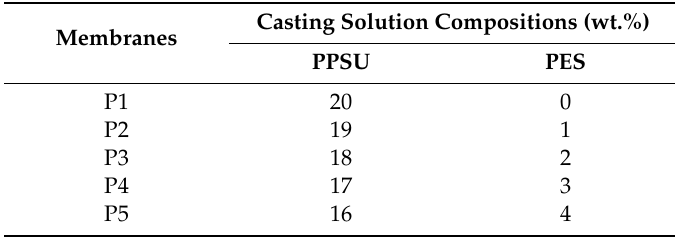
Table1. Castingsolutioncompositionofpolyphenylsulfone-polyethersulfone(PPSU-PES)membranes. Table 1. Casting solution composition of poly phenyl sulfone-polyether sulfone (PPSU-PES) Casting Solution Compositions membranes. Membranes